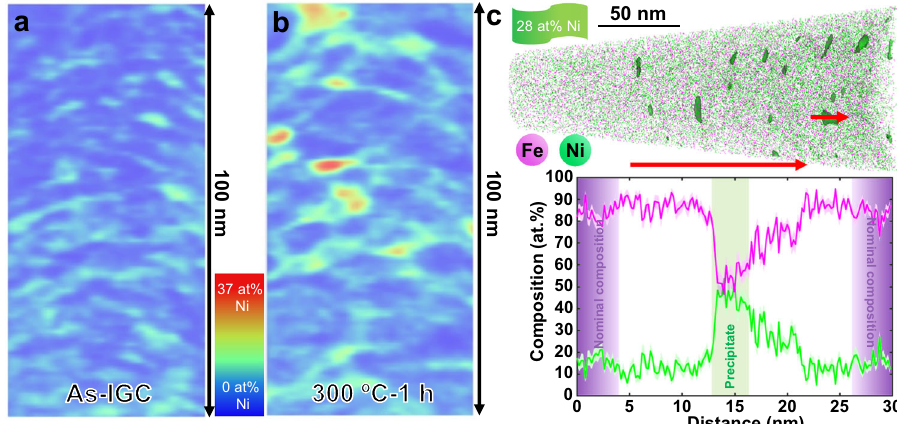
Fig. 2 | High-resolution chemical analysis of the IGC nanograined Fe-Ni samples. a , b Three-dimensional reconstruction from atom probe analysis of the IGC and annealed (300°C for 1h) nanograined Fe-Ni samples. c Quantitative linear analysis of the annealed nanograined Fe-Ni